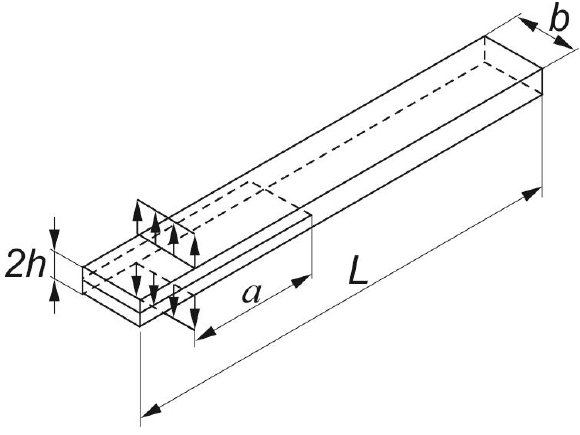
Figure 1. Double cantilever beam (DCB) specimen configuration.